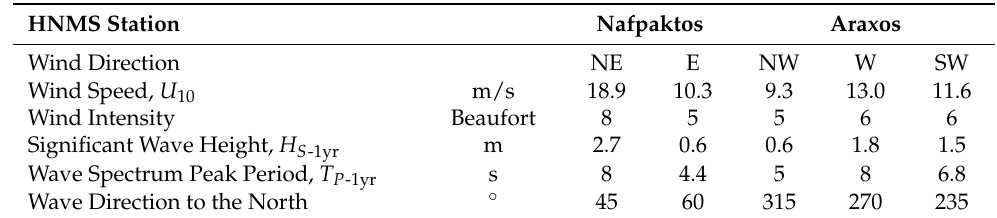
Table 1. Wind and wave data with T r = 1 year, for each wind direction, calculated with the use of the data provided by the nearest to the study area meteorological stations.